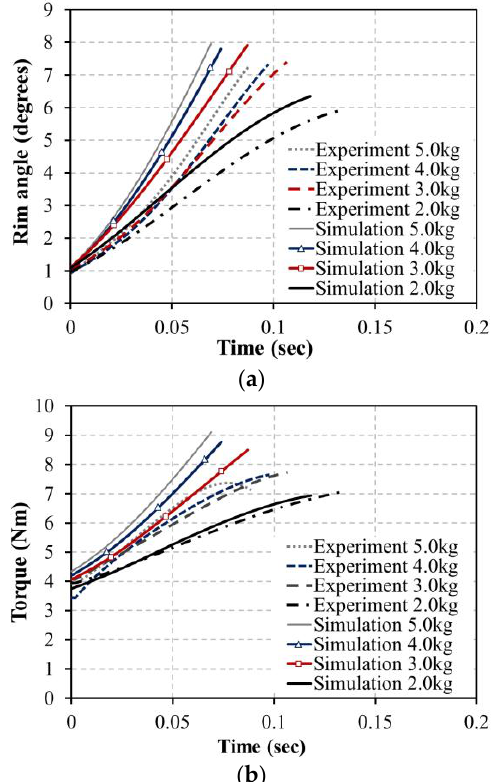
Figure 12. Comparison of simulations and experiments in the dropping weight test for ( a ) handrim angle and ( b ) torque.